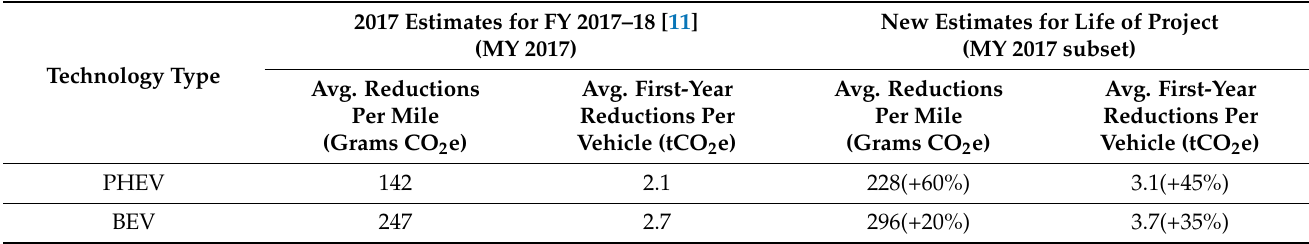
Table 4. Comparison of Model Year 2017 GHG Reductions for